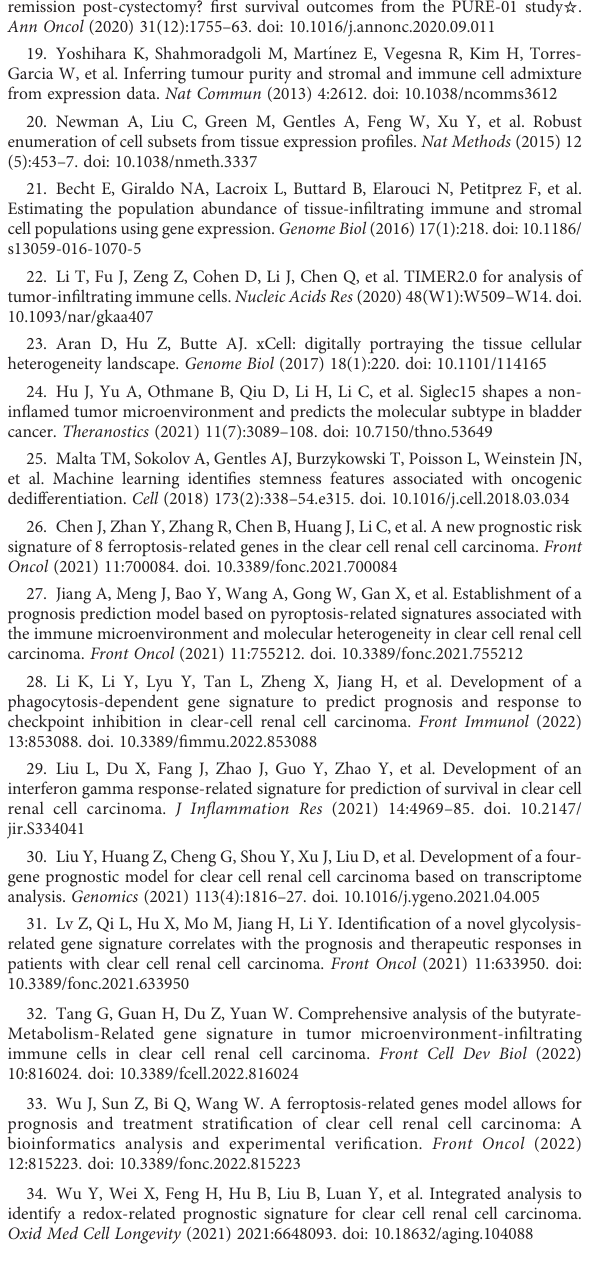
SUPPLEMENTARY FIGURE 1 The expression feature and prognostic function of claudin family genes in kidney cancer. (A) The difference in the expression level of each claudin gene between tumor and normal tissues in kidney renal clear cell carcinoma (KIRC) (sample size, cancer vs normal: 530 vs 72), kidney renal papillary cell carcinoma (KIRP) (288 vs 32) and kidney chromophobe (KICH) (66 vs 25). (B) Forest plots illustrating univariate analyses for overall survival strati fi cation with each claudin gene. CLDN13 and CLDN21 are not included because no valid expression data is